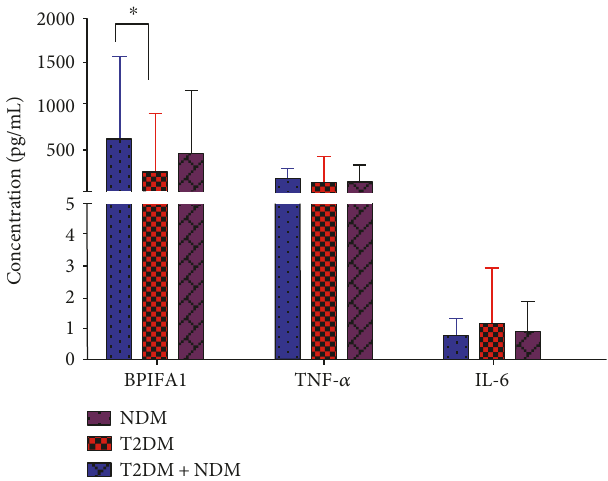
Figure 1: A histogram showing the concentrations of salivary BPIFA1, TNF- α , and IL-6 (pg/mL, median (IQR)) in NDM and T2DM subjects. The blue stripes represent NDM subjects, the red stripes represent T2DM subjects, and the purple stripes represent all subjects. Each group is presented by median (stripes) and interquartile range (bars). Salivary BPIFA1 concentration was signi fi cantly higher in the NDM group than in the T2DM group. The signi fi cant di ff erences are indicated by an asterisk ( ∗ P = 0 031 ). No signi fi cant di ff erence in TNF- α or IL-6 concentration was observed between T2DM and NDM